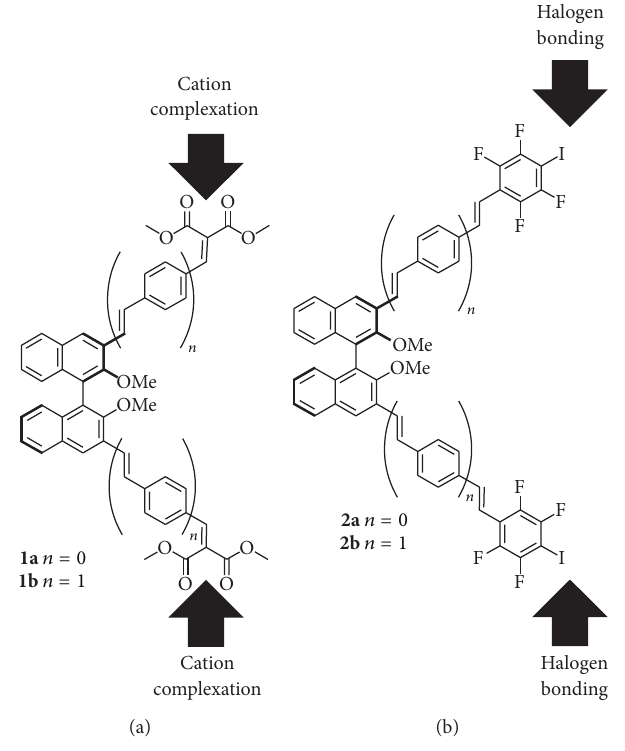
Figure 2: Target compounds subject of this